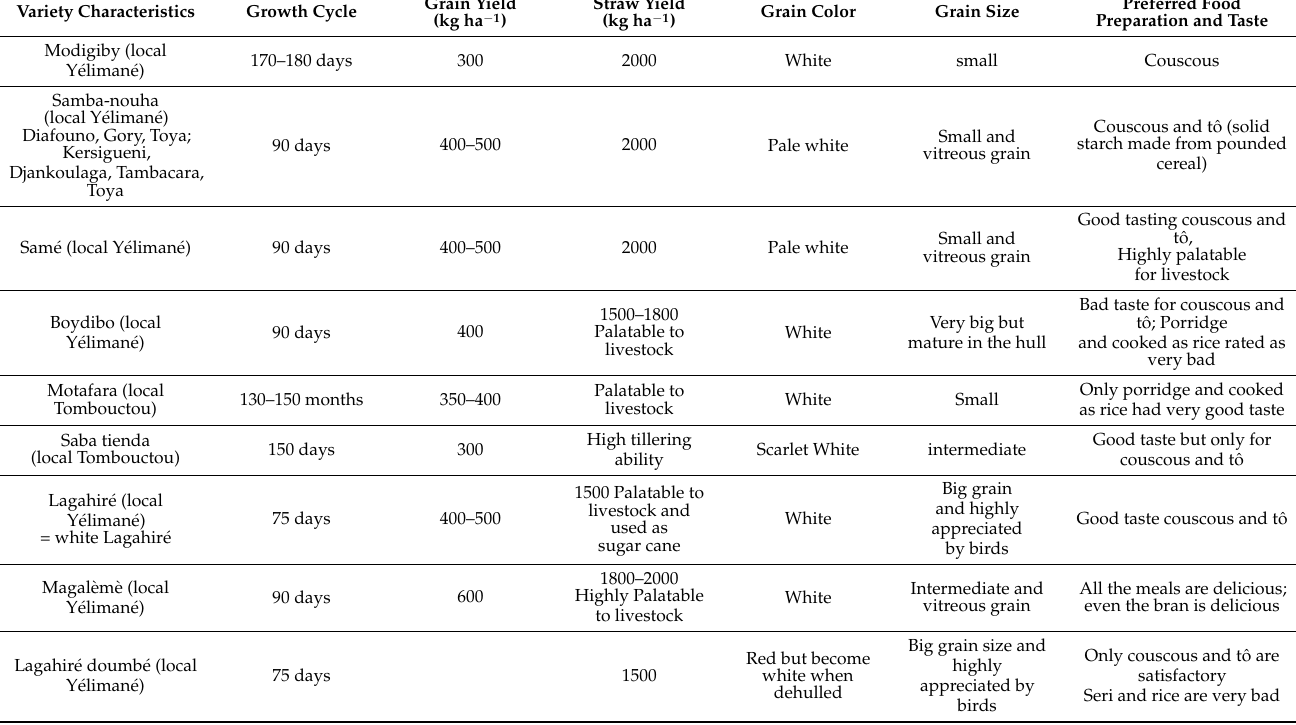
Table 1. Farmers’ characterization of sorghum varieties in flood recession area of Y é liman é